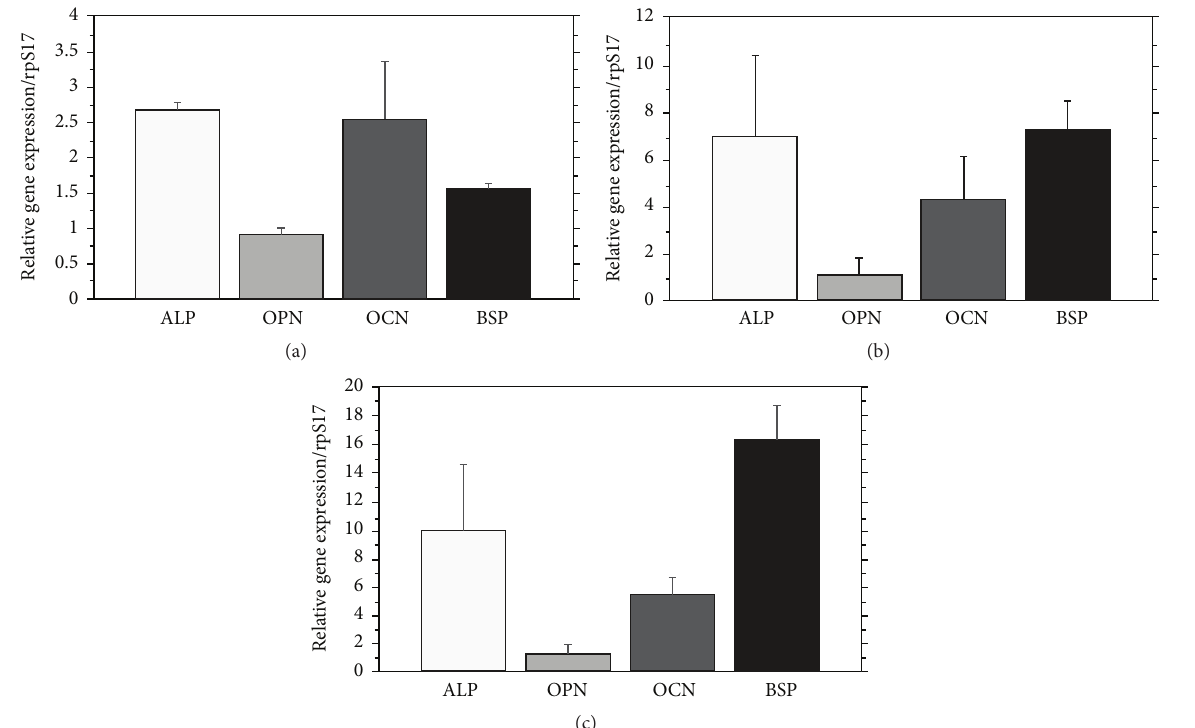
Figure 3: RT-PCR for four calcification-related genes: (a) FC-positive group (group 2), (b) FC-negative and BGP-positive group (group 3), and (c) FC-positive and BGP-positive group (group 4). Each bar represents the SD of triplicate